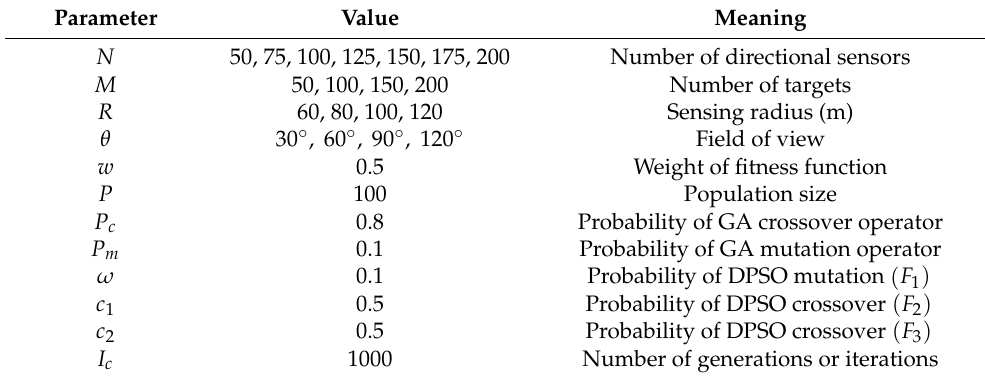
Table 1. Simulation